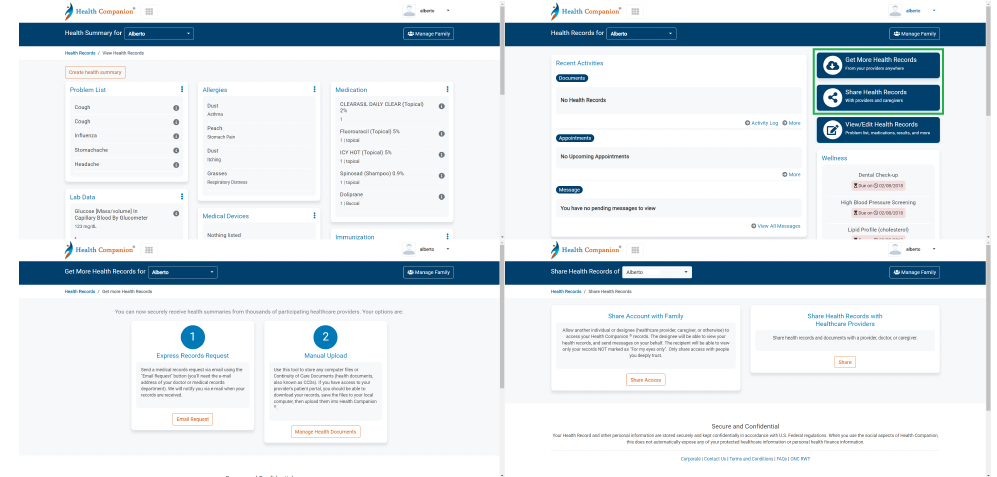
Figure 14. Health Companion screen